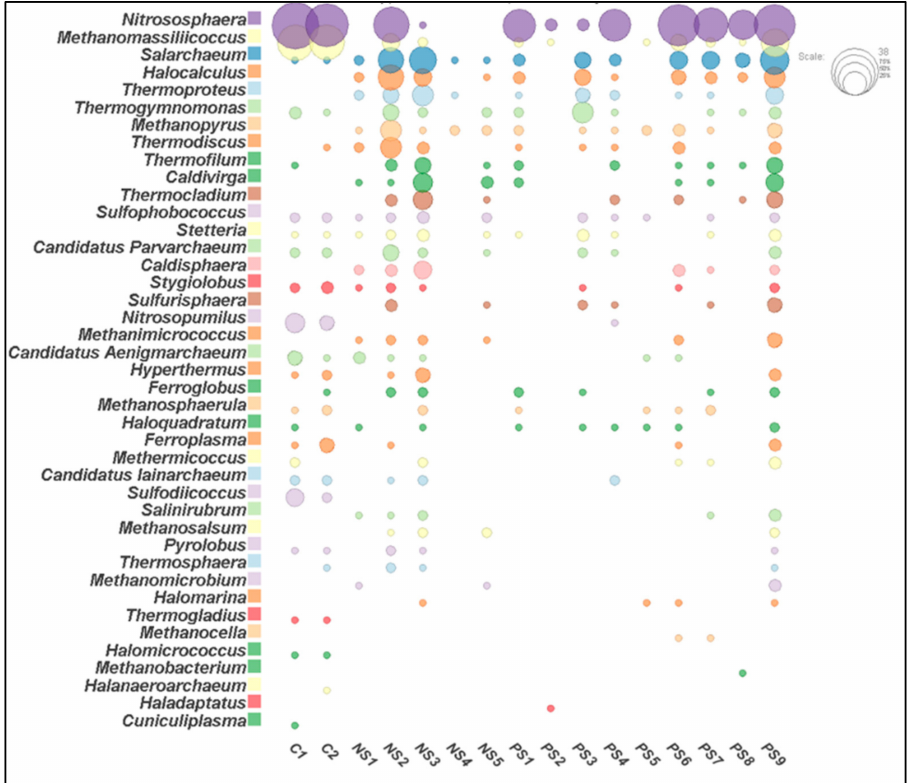
Figure 5. Bubble plot representing genus level distribution in control (C1, C2) and explosives contaminated (NS1-PS9) samples. The scale represents the percentage at the genus level. Image was constructed in MEGAN [29]